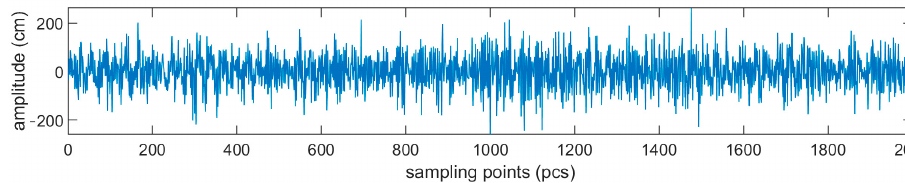
Figure 14. Random noise of the actual micro-seismic data.